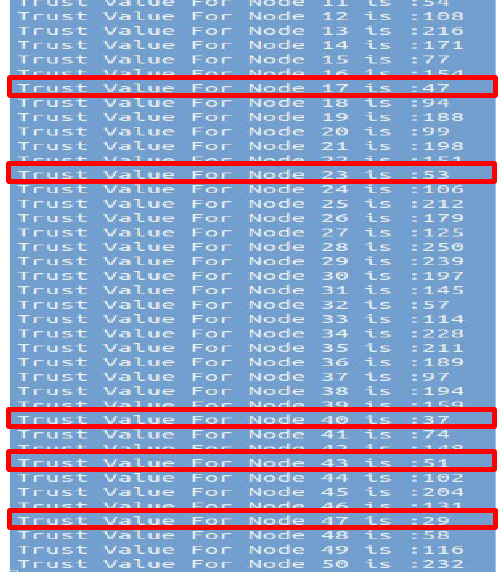
Figure 6 . Simulation environment of MANET-IoT